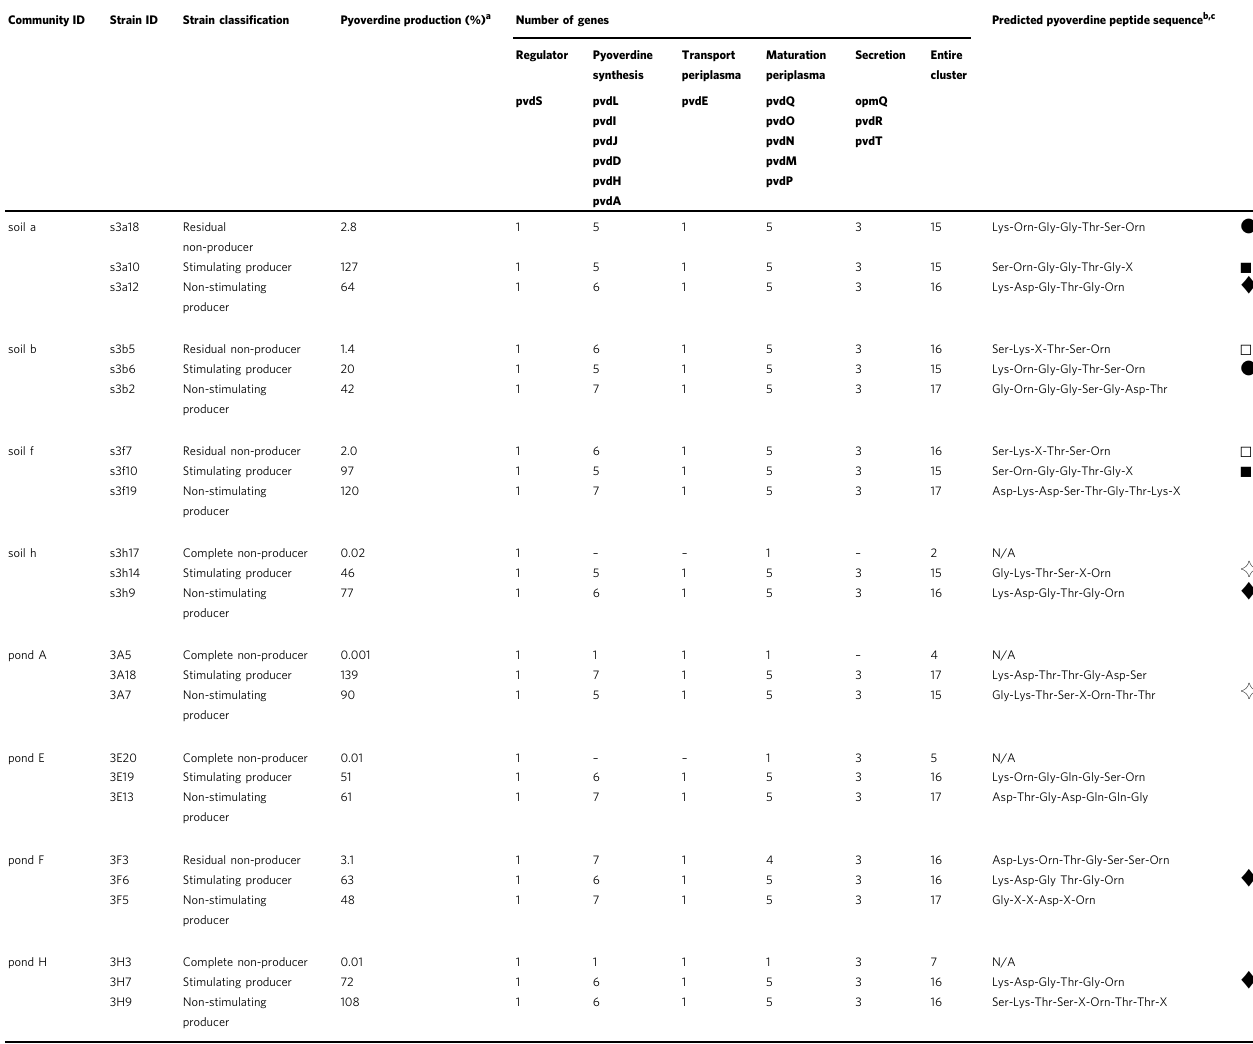
Table 1 Characterisation of the pyoverdine locus and prediction of the pyoverdine amino acid backbone for natural Pseudomonas isolates